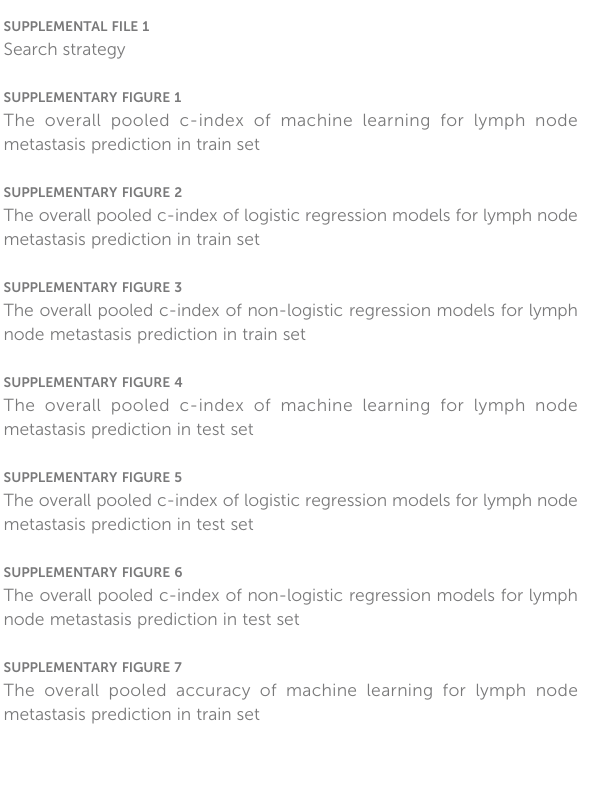
SUPPLEMENTARY FIGURE 8 The overall pooled accuracy of logistic regression models for lymph node metastasis prediction in train set SUPPLEMENTARY FIGURE 9 The overall pooled accuracy of non-logistic regression models for lymph node metastasis prediction in train set SUPPLEMENTARY FIGURE 10 The overall pooled accuracy of machine learning for lymph node metastasis prediction in test set SUPPLEMENTARY FIGURE 11 The overall pooled accuracy of logistic regression models for lymph node metastasis prediction in test set SUPPLEMENTARY FIGURE 12 The overall pooled accuracy of non-logistic regression models for lymph node metastasis prediction in test set SUPPLEMENTARY FIGURE 13 The overall pooled c-index for predicting lymph node metastasis of early- gastric cancer in train set SUPPLEMENTARY FIGURE 14 The overall pooled c-index for predicting lymph node metastasis of early- gastric cancer in test set SUPPLEMENTARY FIGURE 15 The overall pooled c-index for predicting lymph node metastasis of advanced gastric cancer in train set SUPPLEMENTARY FIGURE 16 The overall pooled c-index for predicting lymph node metastasis of advanced gastric cancer in test set SUPPLEMENTARY FIGURE 17 The overall pooled accuracy for predicting lymph node metastasis of early-gastric cancer in train set SUPPLEMENTARY FIGURE 18 The overall pooled accuracy for predicting lymph node metastasis of early-gastric cancer in test set SUPPLEMENTARY FIGURE 19 The overall pooled accuracy for predicting lymph node metastasis of advanced gastric cancer in train set SUPPLEMENTARY FIGURE 20 The overall pooled accuracy for predicting lymph node metastasis of advanced gastric cancer in test